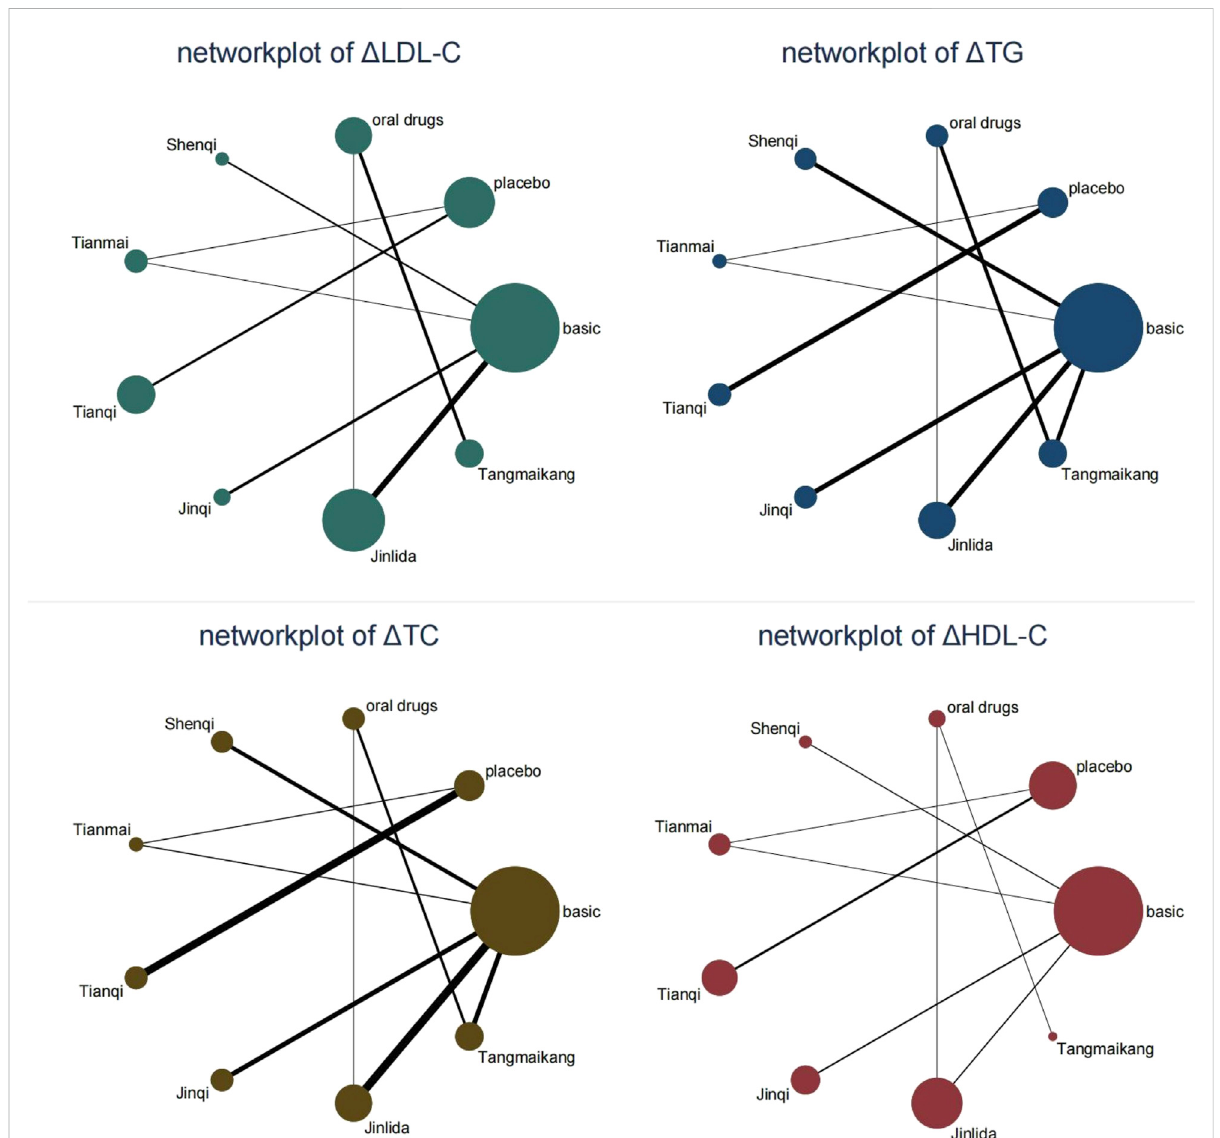
FIGURE 3 Network evidence plots. Legend: “ basic ” means the basic lifestyle modi fi cation without any drugs. “ oral drug ” means oral hypoglycemic drugs (metformin in the included studies) based on the lifestyle modi fi cation.